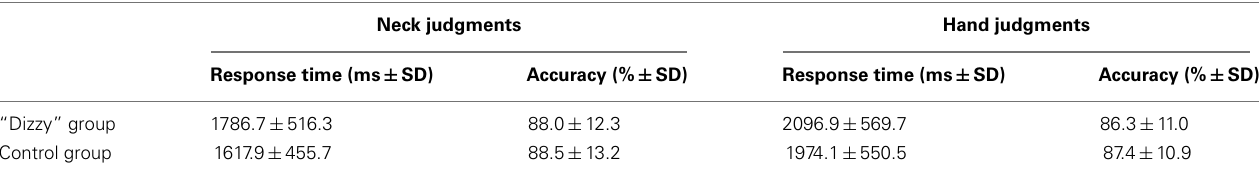
Table 1 | Response time and accuracy for left/right neck rotation judgments and left/right hand judgments in people with and without dizziness symptoms.